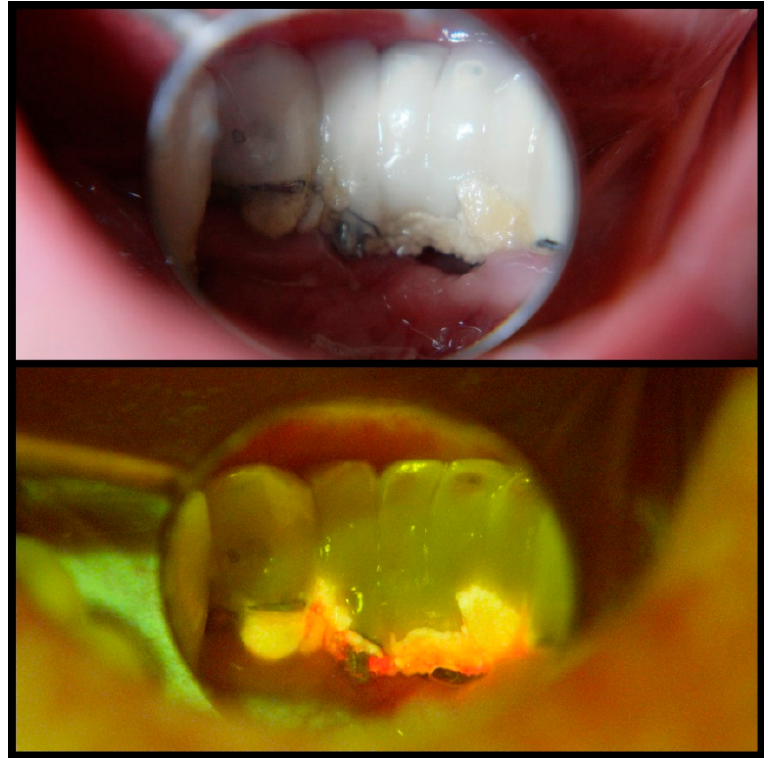
Figure 2. Intraoral clinical view of a mandibular anterior implant-supported restoration under regular operating light, indicating substantial plaque accumulation on the lingual aspect ( upper panel ). A UV headlight and special-filter loupes reveal active bacteria through orange and red fluorescence ( lower panel ) and allow for better detection and removal of plaque. Such a hands-free device does not limit the clinician during clinical treatment procedures.